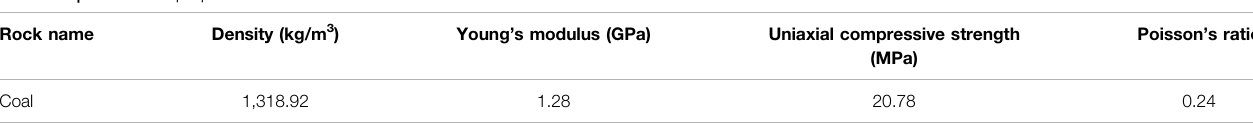
TABLE 1 | Mechanical properties of coal.